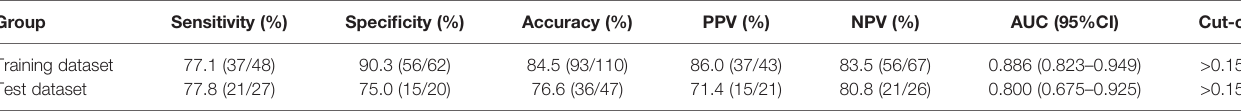
TABLE 4 | Performance of nomogram for MVI